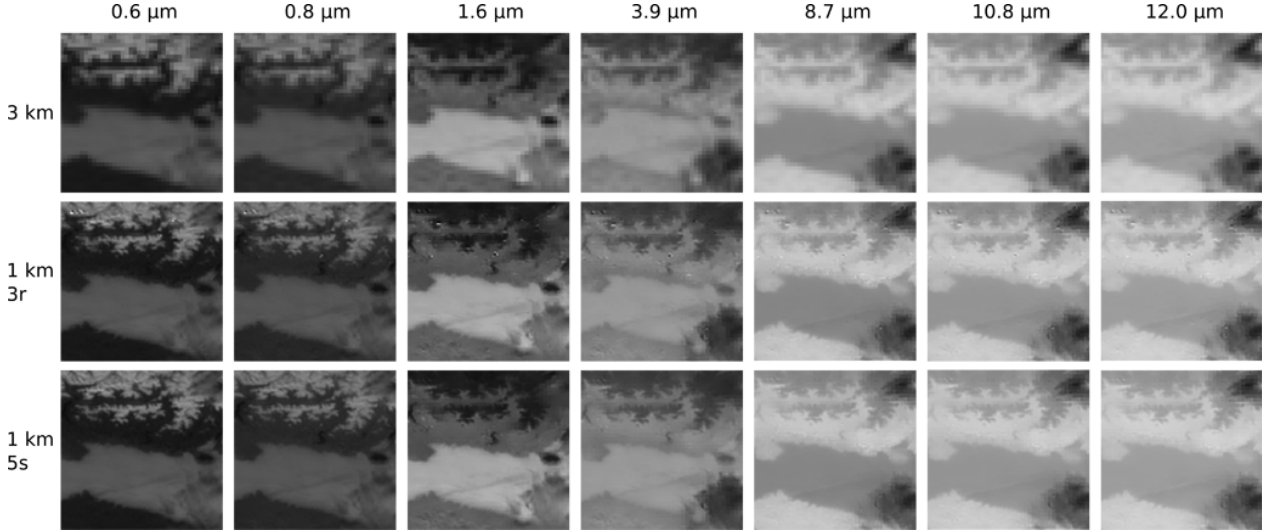
Fig. 6. Sharpening results for different variations of the pan-sharpening algorithm and each of SOFOS’ input channels showing fog in the Po Valley on 22 December 2008. In order to achieve better comparability the 3km channels were interpolated to the size of the 1km images via nearest-neighbour interpolation. Table 3. Statistical measures describing the quality of FLS masks based on channels that were sharpened by different variations of the pan-sharpening algorithm as well as on interpolated channels. Bias POD